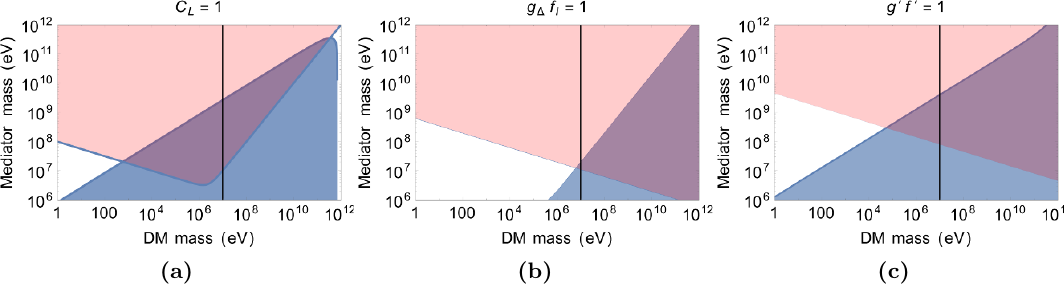
Figure 5. Mass of the mediator vs. mass of DM for (a) fermion-mediated, (b) scalar-mediated and (c) vector-mediated neutrino-DM interactions. The blue and pink regions are allowed from relic density of DM and collisional damping respectively. The region at the left side of the vertical black line is ruled out from the constraint coming from N e(cid:11)